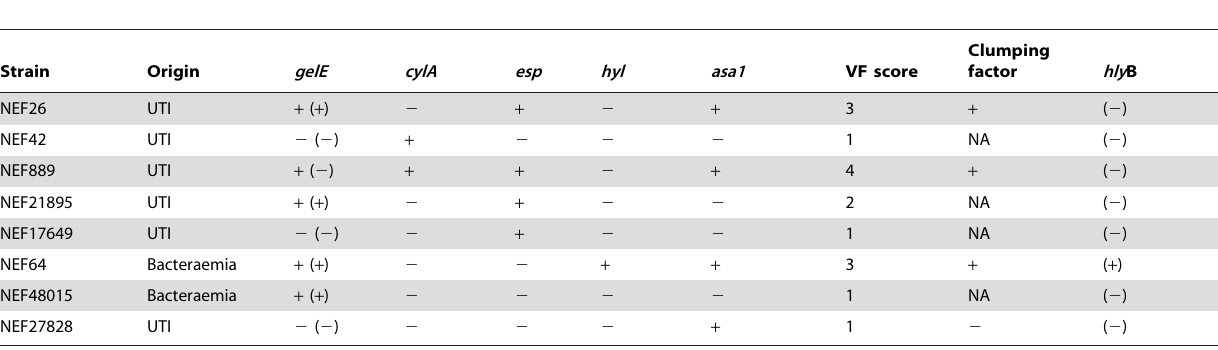
Table 1. Detection of virulence factor (VF)-encoding genes ( asa1, gelE, cylA, esp and hyl ) and production of hemolysin ( hly B), gelatinase and aggregation substance among E. faecalis